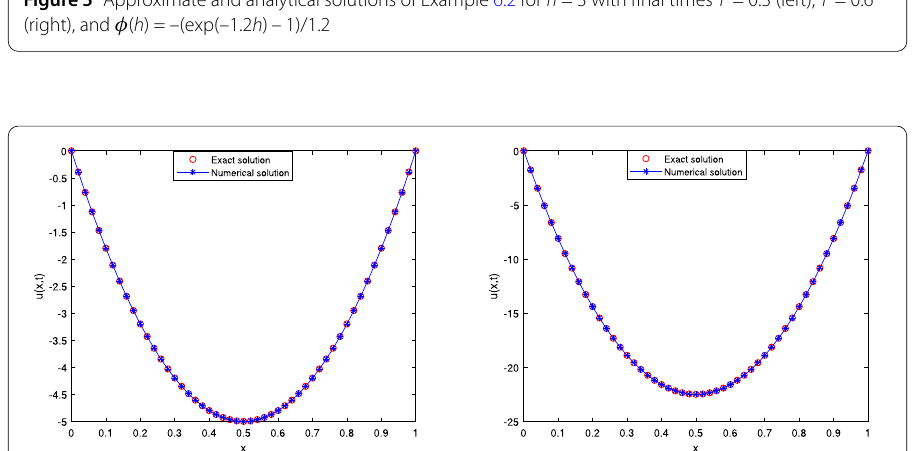
Figure 6 Approximate and exact solutions of Example 6.2 for n = 3 with final times T = 5 (left), T = 10 (right), and φ ( h ) = 4sinh( h /4)